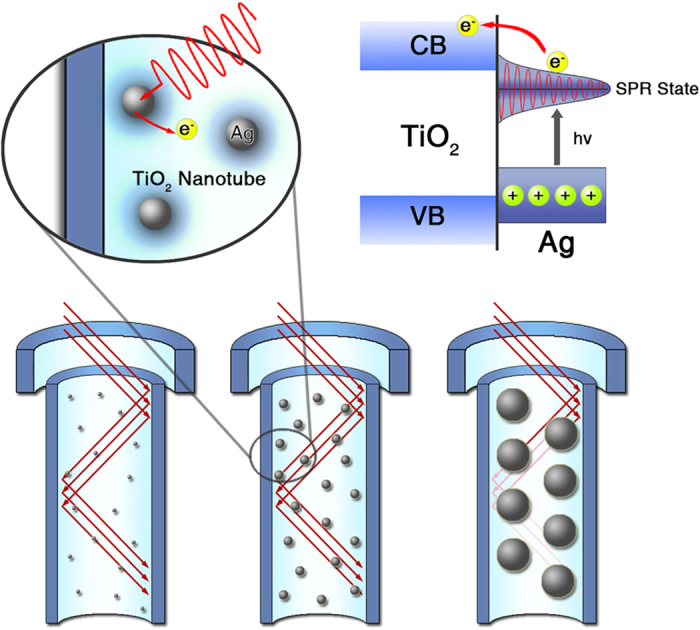
Schematic diagram.The light penetration mechanism in the Ag nanocrytals loaded H-TiO2-NTAs.